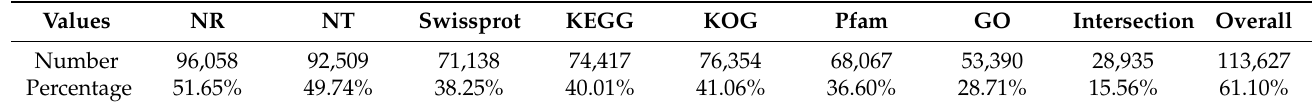
Table 3. General Annotation List of Gene